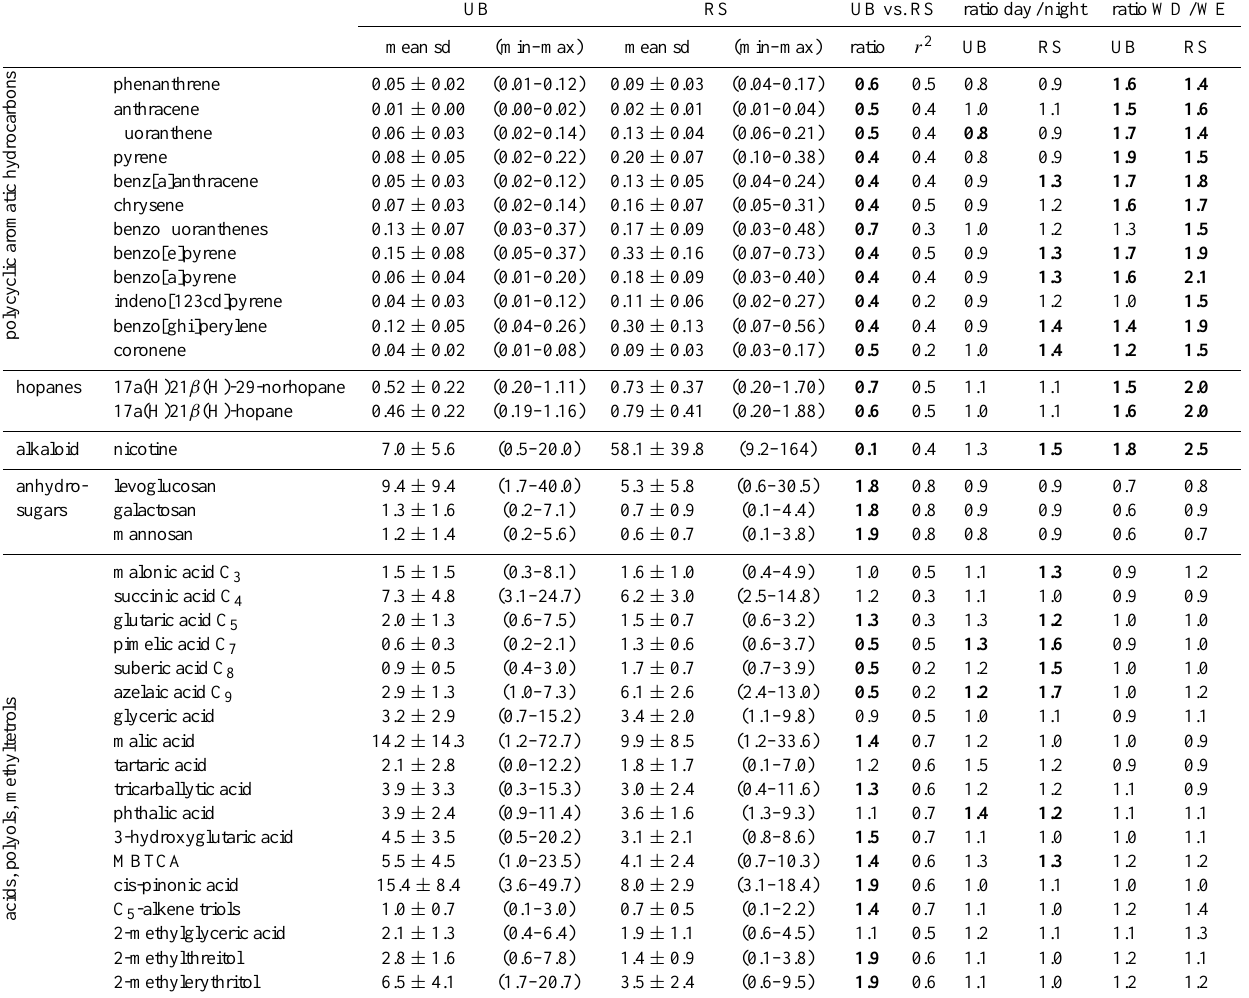
Table 1. Summary of the concentrations (ngm − 3 ) of analyzed organic tracer compounds. The results indicated in bold showed significant ( t test, p < 0 . 05) differences between sites, day and night, or between weekday (WD) and weekends/holidays